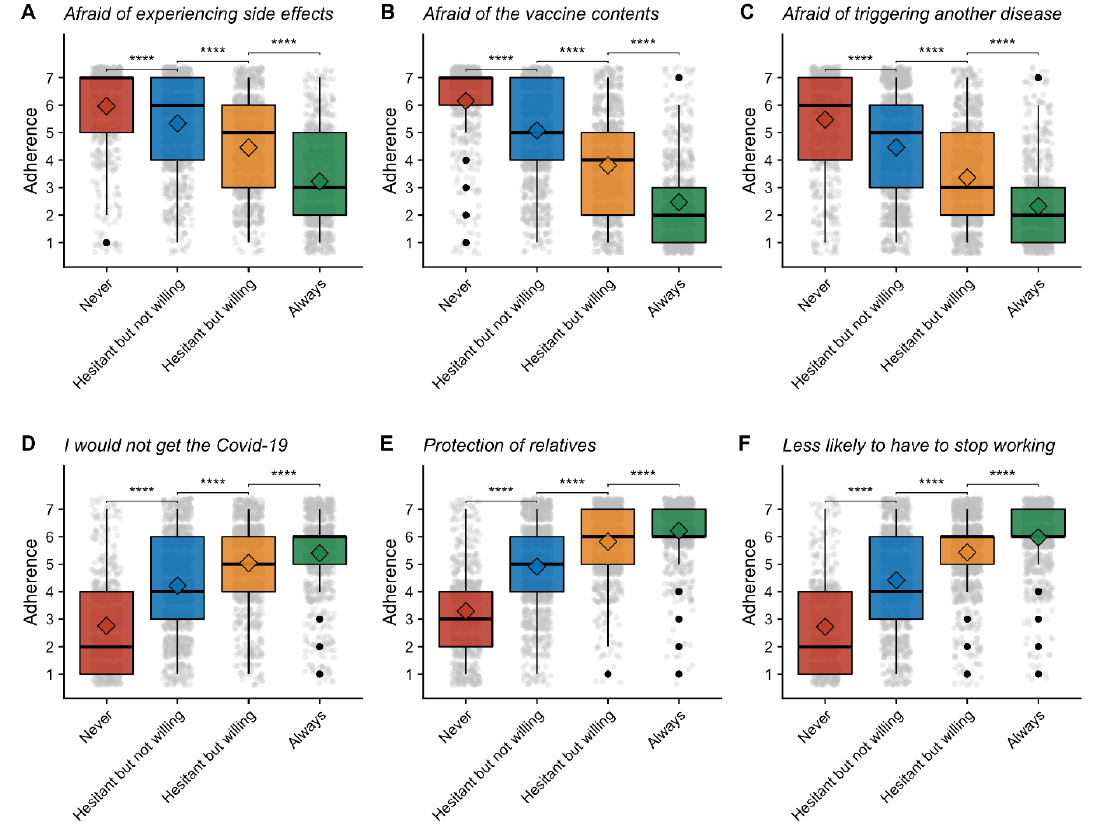
Figure 5. Perception of vaccination against COVID-19 within each cluster. Boxplots of the intensity of perceptions and beliefs about COVID-19, ranging from 1 (“Not at all”) to 7 (“Absolutely”). Black dot are representing outliers and greys dots the distribution of answers. For each panel, participants were asked to answer to the question “If you were to be vaccinated against COVID-19 . . . ”: ( A ) “ . . . I would be afraid of experiencing side effects” ( B ) “ . . . would be afraid of the contents of the vaccine” ( C ) “ . . . I would be afraid of triggering another disease” ( D ) “ . . . I would not get the virus”, ( E ) “ . . . I would be protecting patients and/or my family”, ( F ) “ . . . I would be less likely to have to stop working”. **** for p -value < 0.001, Wilcoxon-test.